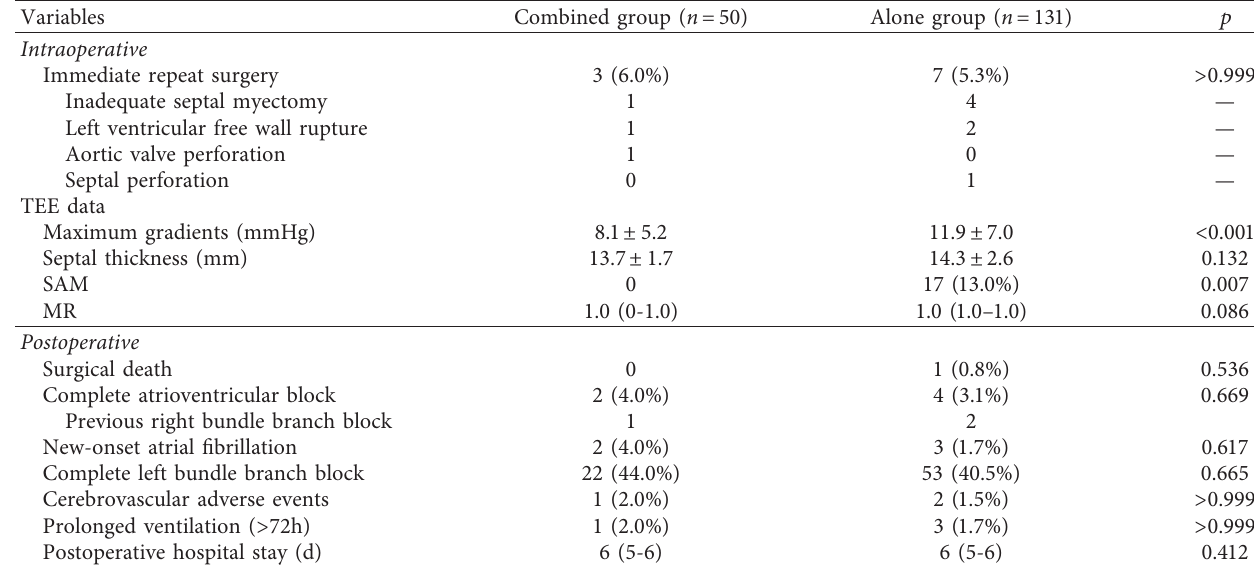
Table 3: Perioperative outcomes.